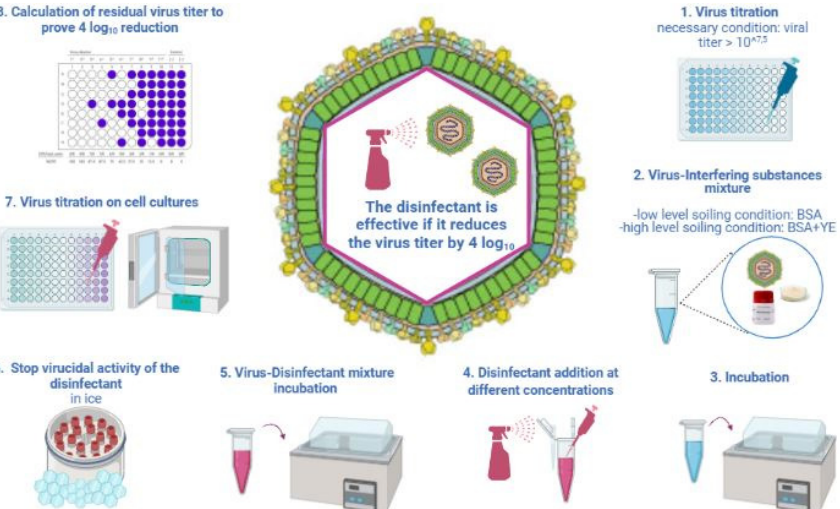
Figure 1. Quantitative suspension test for virucidal activity against ASFV according to the UNI EN 14675:2015 standard. BSA: bovine serum albumin; YE: yeast extract. Created in Biorender.com (https://biorender.com/), last accessed on 8 March 2022.